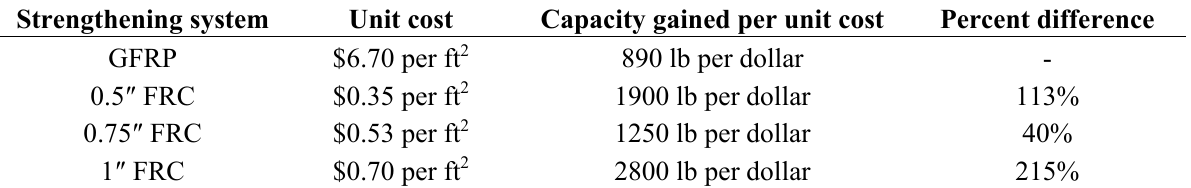
Table 6. Cost comparison between GFRP sheets and FRC